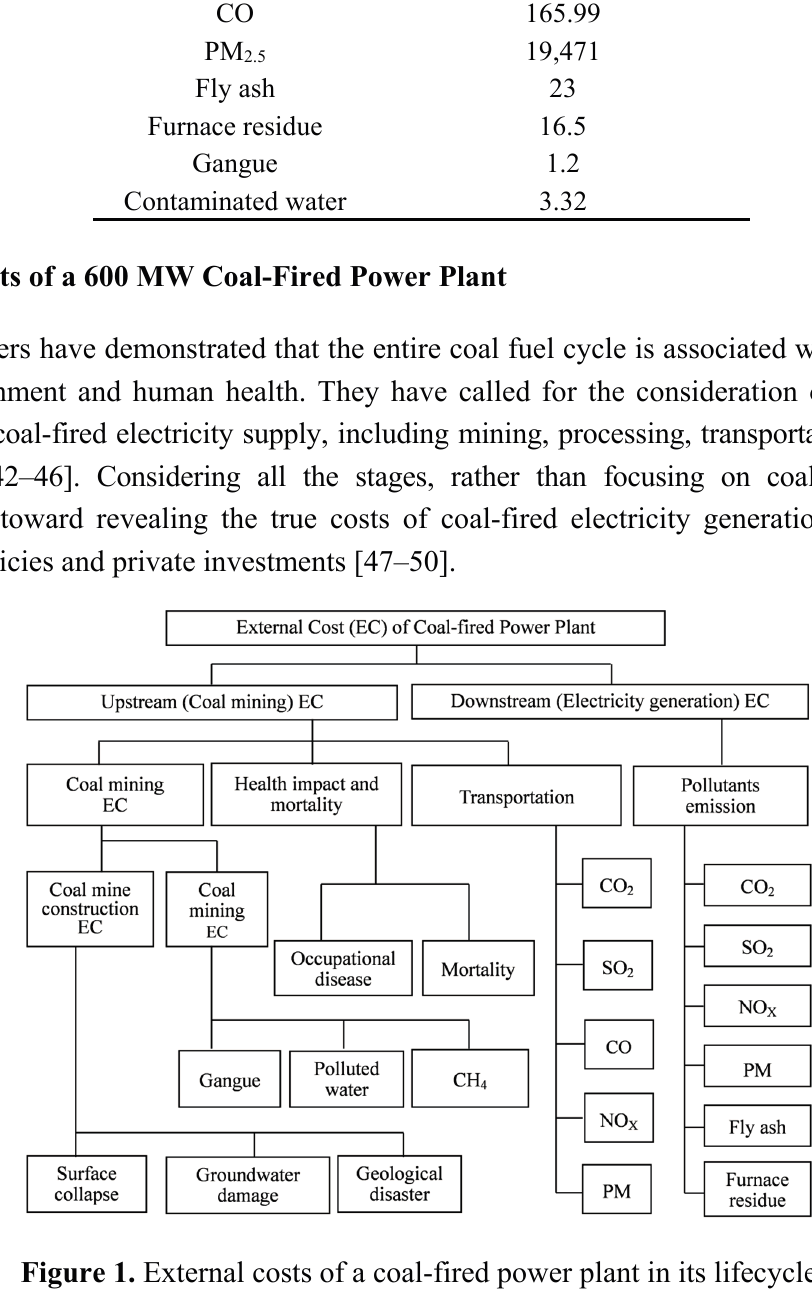
Figure 1. External costs of a coal-fired power plant in its